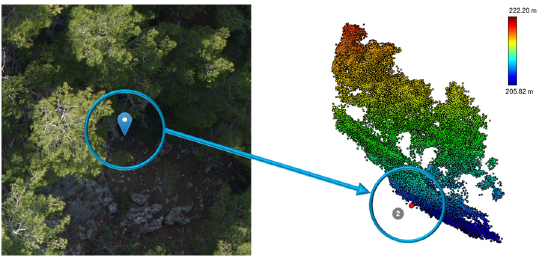
Figure 31. Sample false-positive where we have a sudden elevation change covered by canopy.